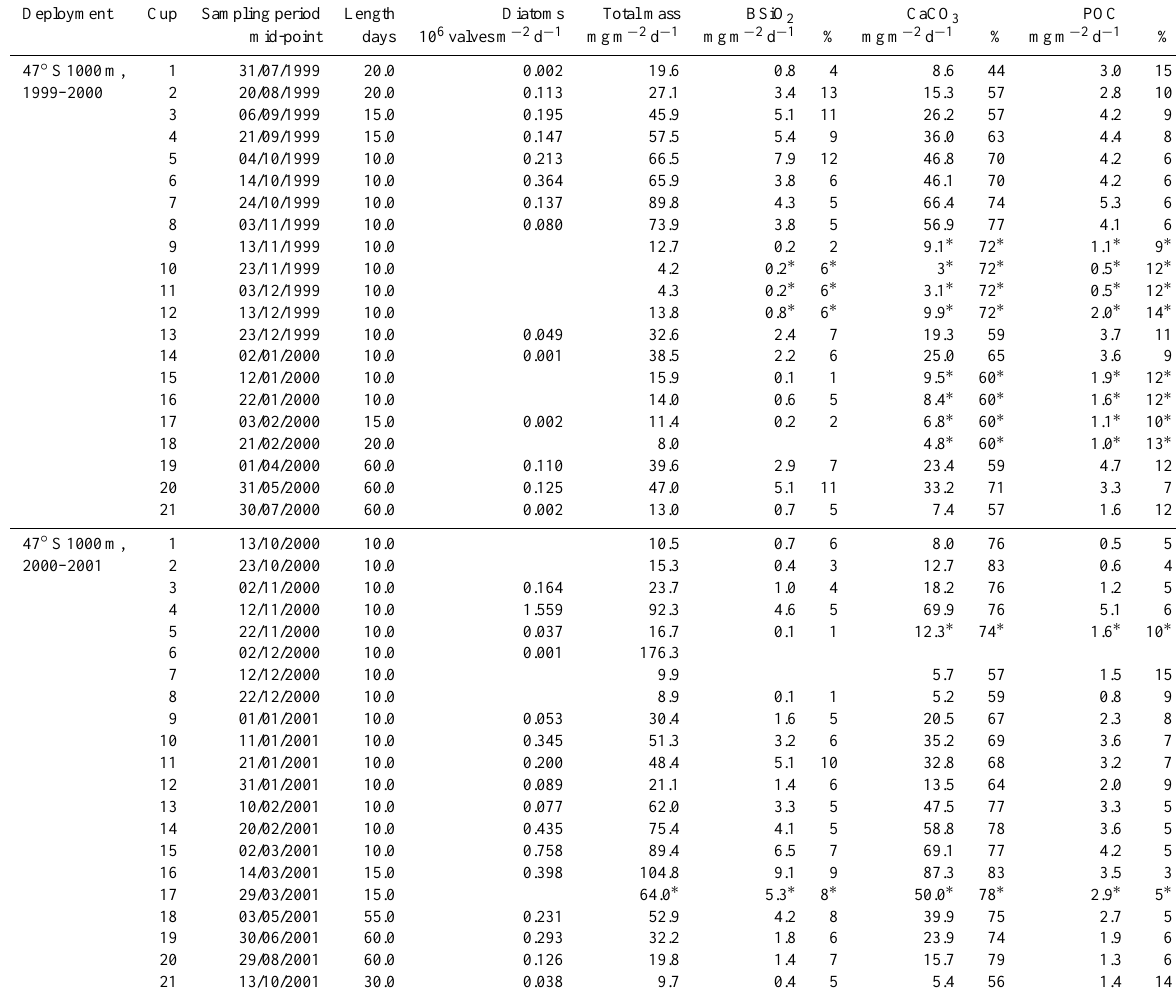
Table 2. Individual cup fluxes for the <1mm fraction.